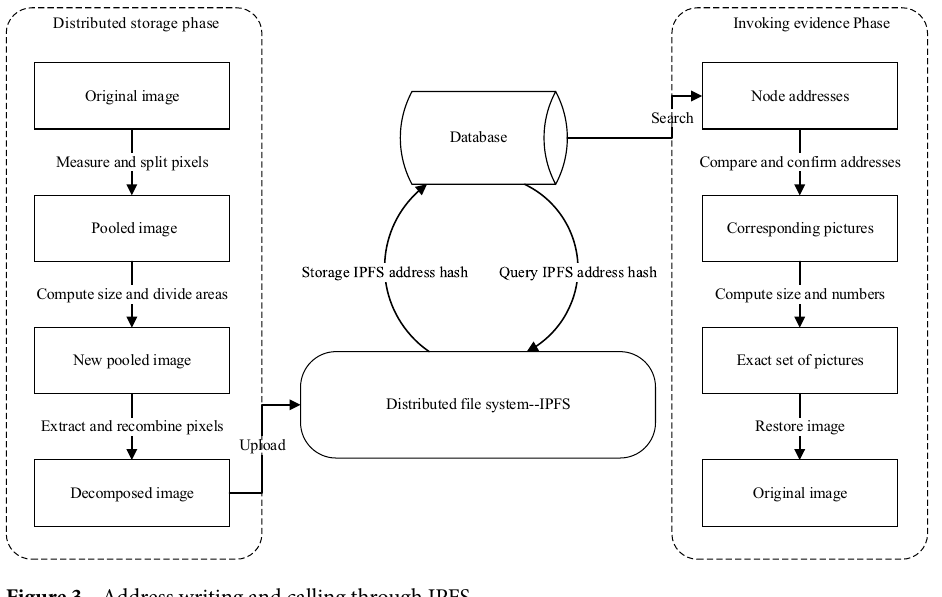
Figure 3. Address writing and calling through